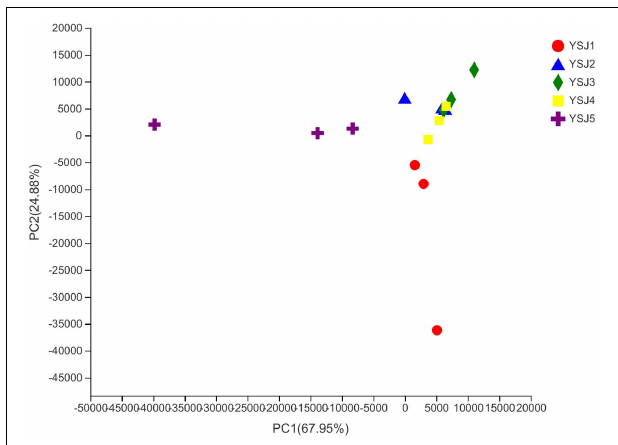
FIGURE 5 | Multiple sample principal component analysis (PCA) of the OTU level. Both selected principal component axes are represented by the x-axis and y-axis , and percentage represents the difference in sample composition by principal component; scales of x-axis and y-axis represent relative distances. Samples are represented by different color points or shapes in different groups. Closeness of points or shapes represents the similarity level between fungal species composition.